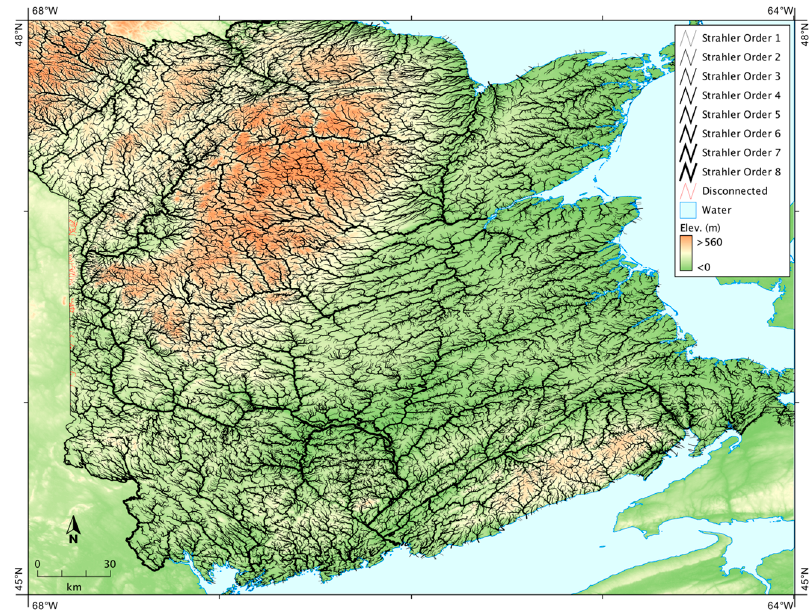
Figure 3. Southern Ontario study area drainage network with line thickness proportional to Strahler stream order.